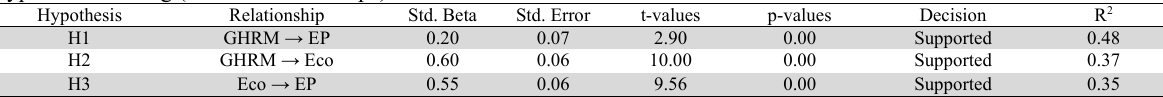
Hypothesis Testing (Direct Relationships) Hypothesis Relationship Std. Beta Std. Error t-values p-values Decision R 2